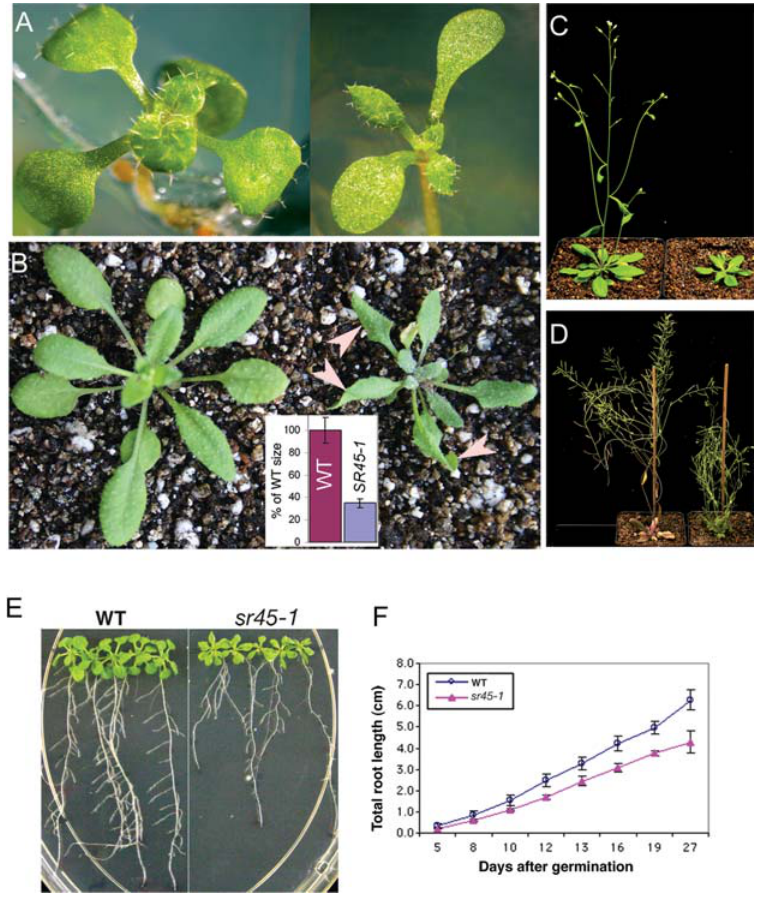
Figure 4. Phenotypic characterization of sr45-1plants. (A–D) Phenotypes of sr45-1 at different growth stages grown under long-days (16-h photoperiod). WT plants are shown on the left side and sr45-1 plants are on the right side of each panel. (A) Eight day-old seedlings on MS plates; Note that sr45-1 has narrow true leaves. (B) Twenty-day-old plants in the soil; several leaves in the sr45-1 plant are curled downward and inward, indicated by arrow-heads. Inset graph in (B) shows the size of sr45-1 compared to WT. (C) Thirty-five-day old plants in soil. (D) Fifty-four-day-old plants in soil; note that WT has completed flowering and most of the siliques have turned brown, whereas, the sr45-1 plant is still flowering. (E) Root growth in sr45-1 and WT plants. A representative photograph of sr45-1 and WT seedlings (27 days after germination) illustrates reduced root growth. (F) Quantification of root growth. Each data point is the mean 6 SEM of 5 plants. (Figure 4E and F). Under most conditions sr45-1 plants were bushy (Figure 4D). The most pronounced phenotypes, flowering time and leaf morphology were chosen for further detailed character- ization.